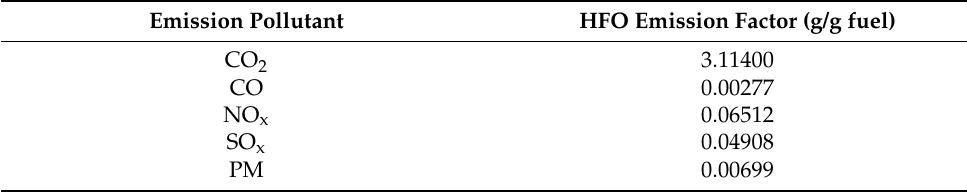
Table 5. Emission factors of